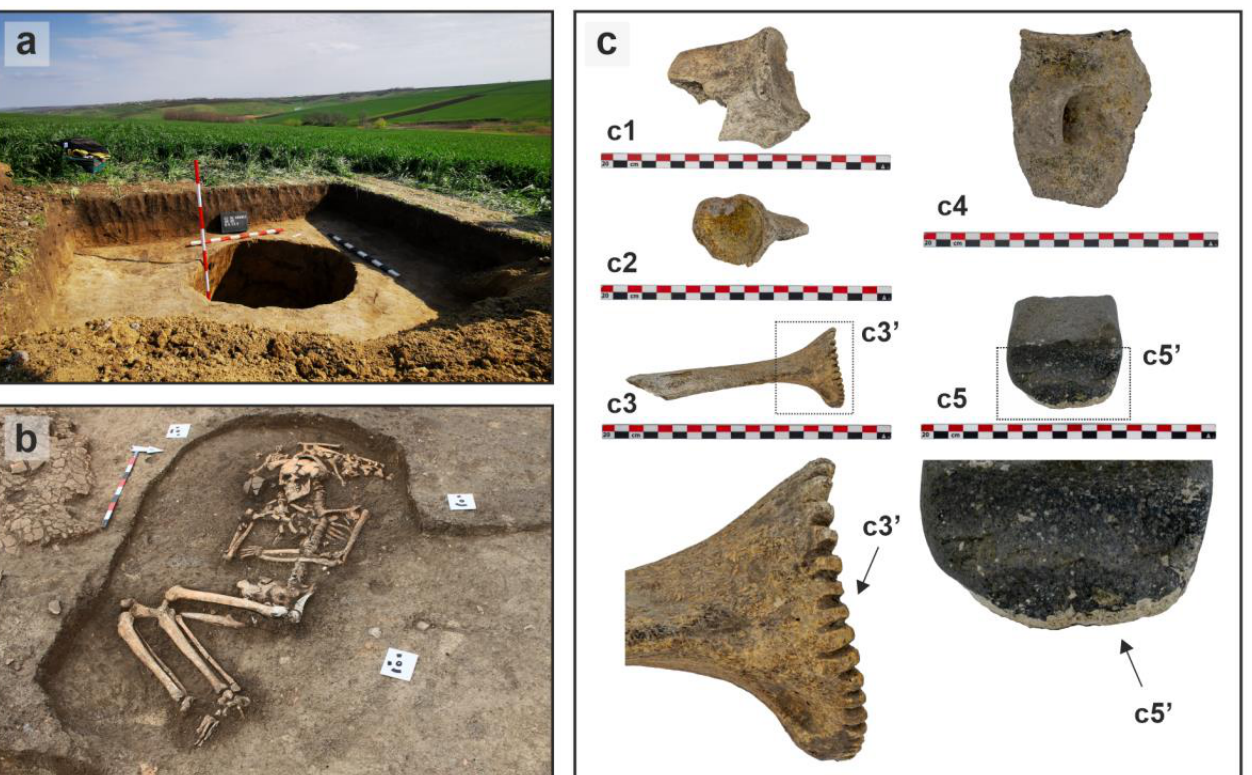
Figure 2. Examples of archaeological remains belonging to Noua Culture (LBA) in the Jijia catchment (NE Romania): ( a ) inside of an LBA site from the Jijia lowland—an excavated ashmound which was visible on aerial photographs and on site; ( b ) a tomb belonging to Noua Culture discovered during the excavation of a Chalcolithic settlement from Jijia-Siret upland; ( c ) LBA tools and ceramic fragments collected from various locations in the Jijia basin: c1, c2 and c3—crenated scapulae used as tools for processing animal skin; c4—a ceramic fragment of a cooking pot; c5—a stone-axe.